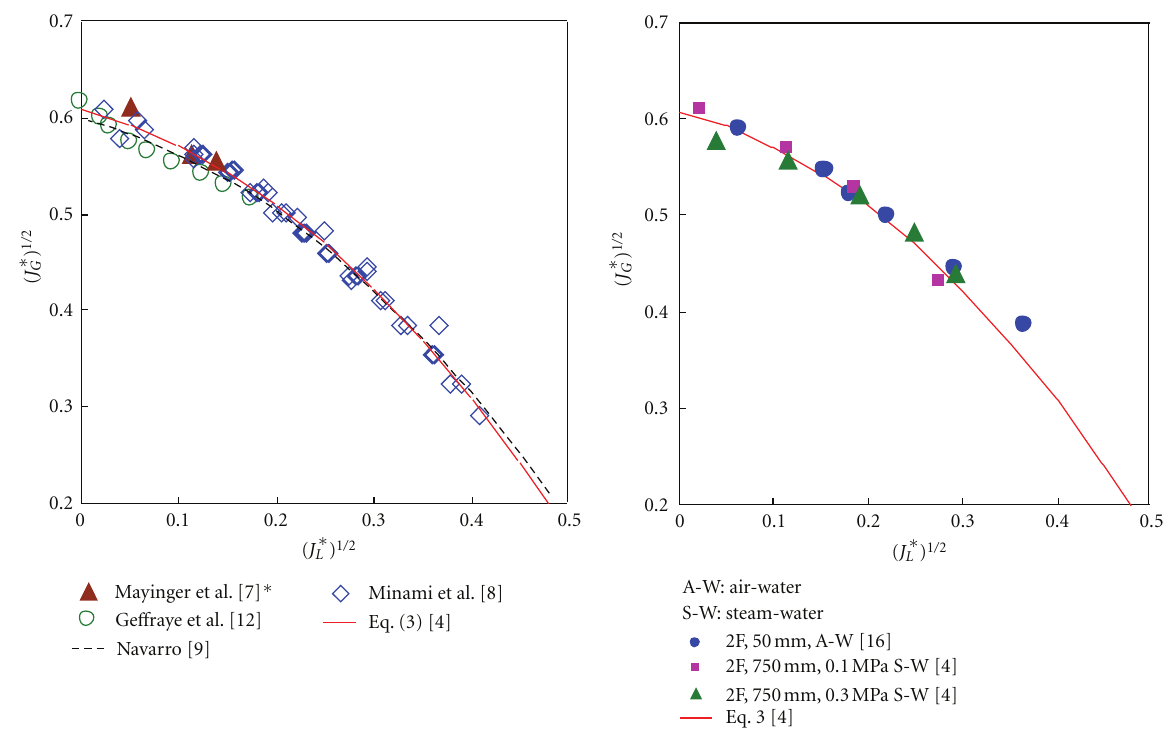
Figure 2: CCFL characteristics.